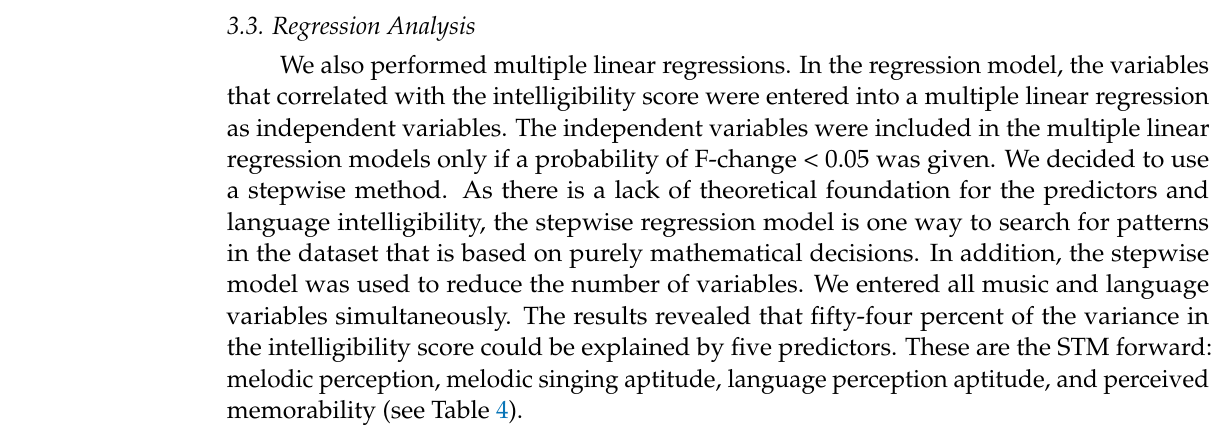
Table 4. The multiple regression models explain the variance in the intelligibility total score.